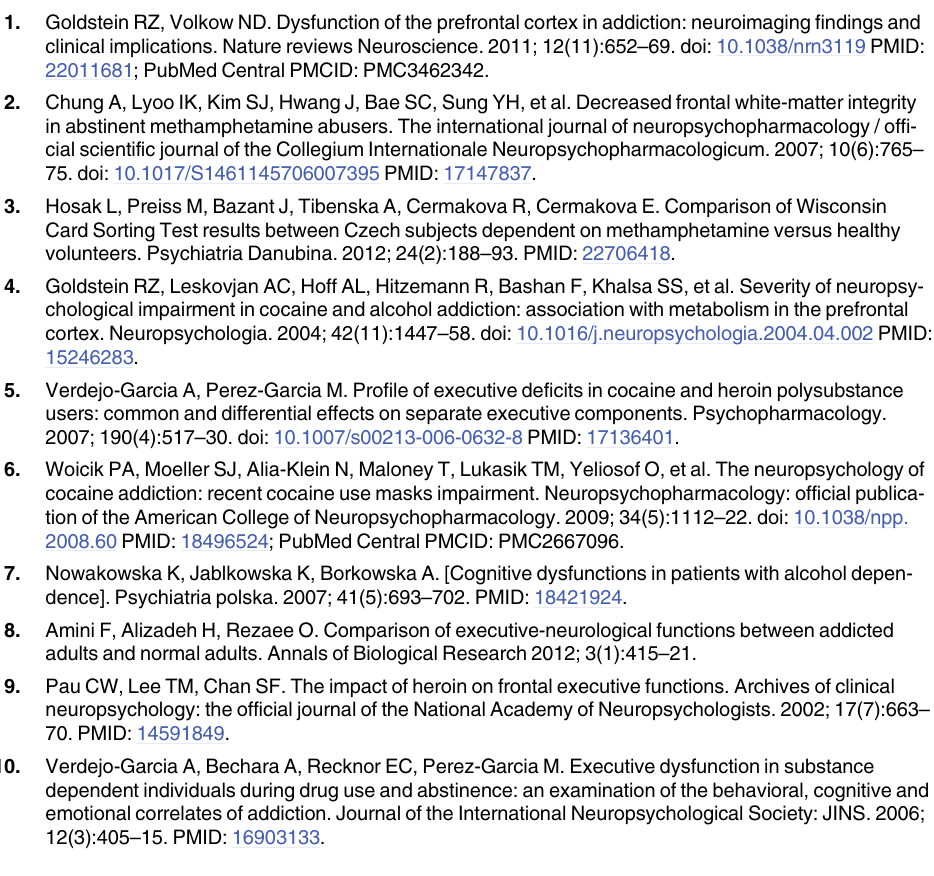
S2 Table. Forward step-wise regression results with whole striatum BP variable, and demographic variables as predictors. S3 Table. Forward step-wise regression results with WCST proportion of non-perseverative errors as the dependent variable, and demographic variables as predictors. S4 Table. Exploratory tests of relationships between D2/D3 receptor availability in extra- striatal regions and executive function